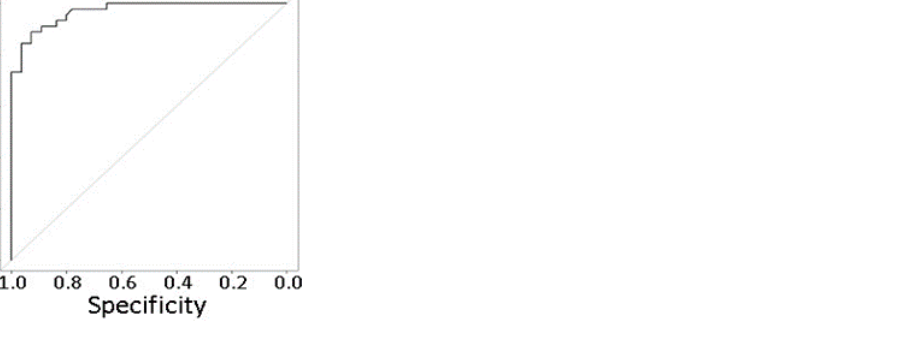
Figure 6. Receiver operating characteristic curve for the UM metastasis prediction model in Table 3. Corrected area under the ROC curve = 0.93.